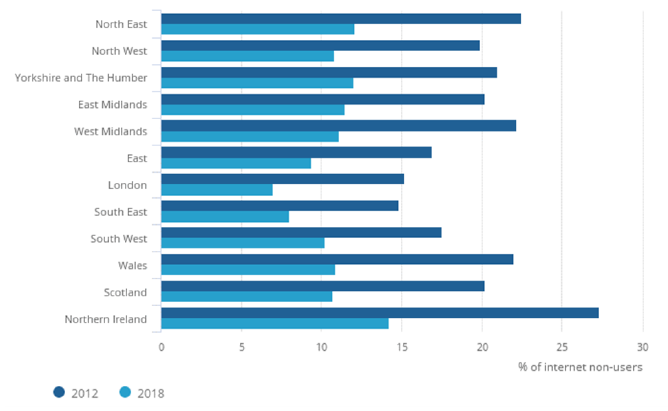
Figure 2: A survey on the percentage of internet non-users in the different UK regions revealed existing regional variations yet an overall decline from 2012 to 2018 (Office for National Statistics